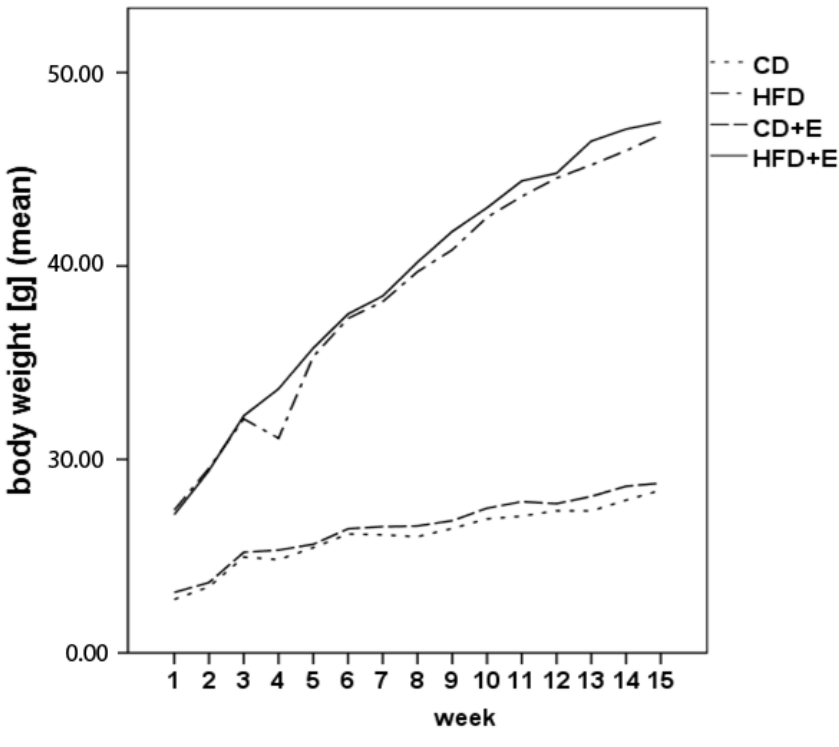
Figure 1. Body weight gain of C57BL/6J male mice over four months ( n = 15) (CD = control diet; HFD = high fat diet; CD + E = control diet plus vitamin E; HFD + E = high fat diet plus vitamin